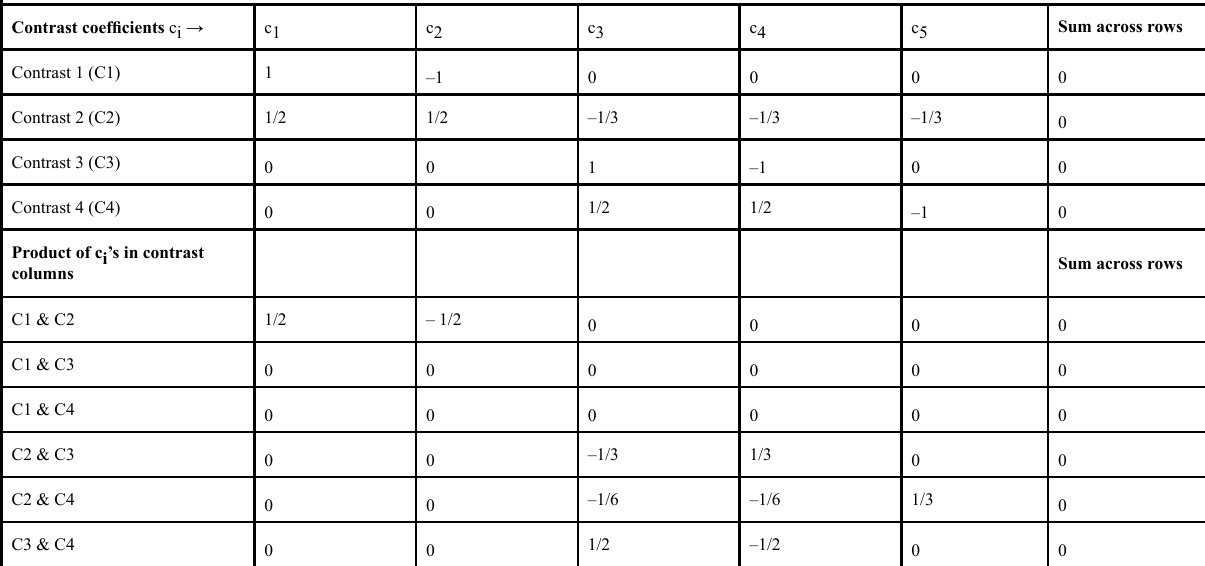
Table 4: A choice of 4 mutually orthogonal linear contrasts for the 5 means μ 1 , μ 2 , μ 3 , μ 4 , μ 5 . Contrast coefficients ci → c1 c2